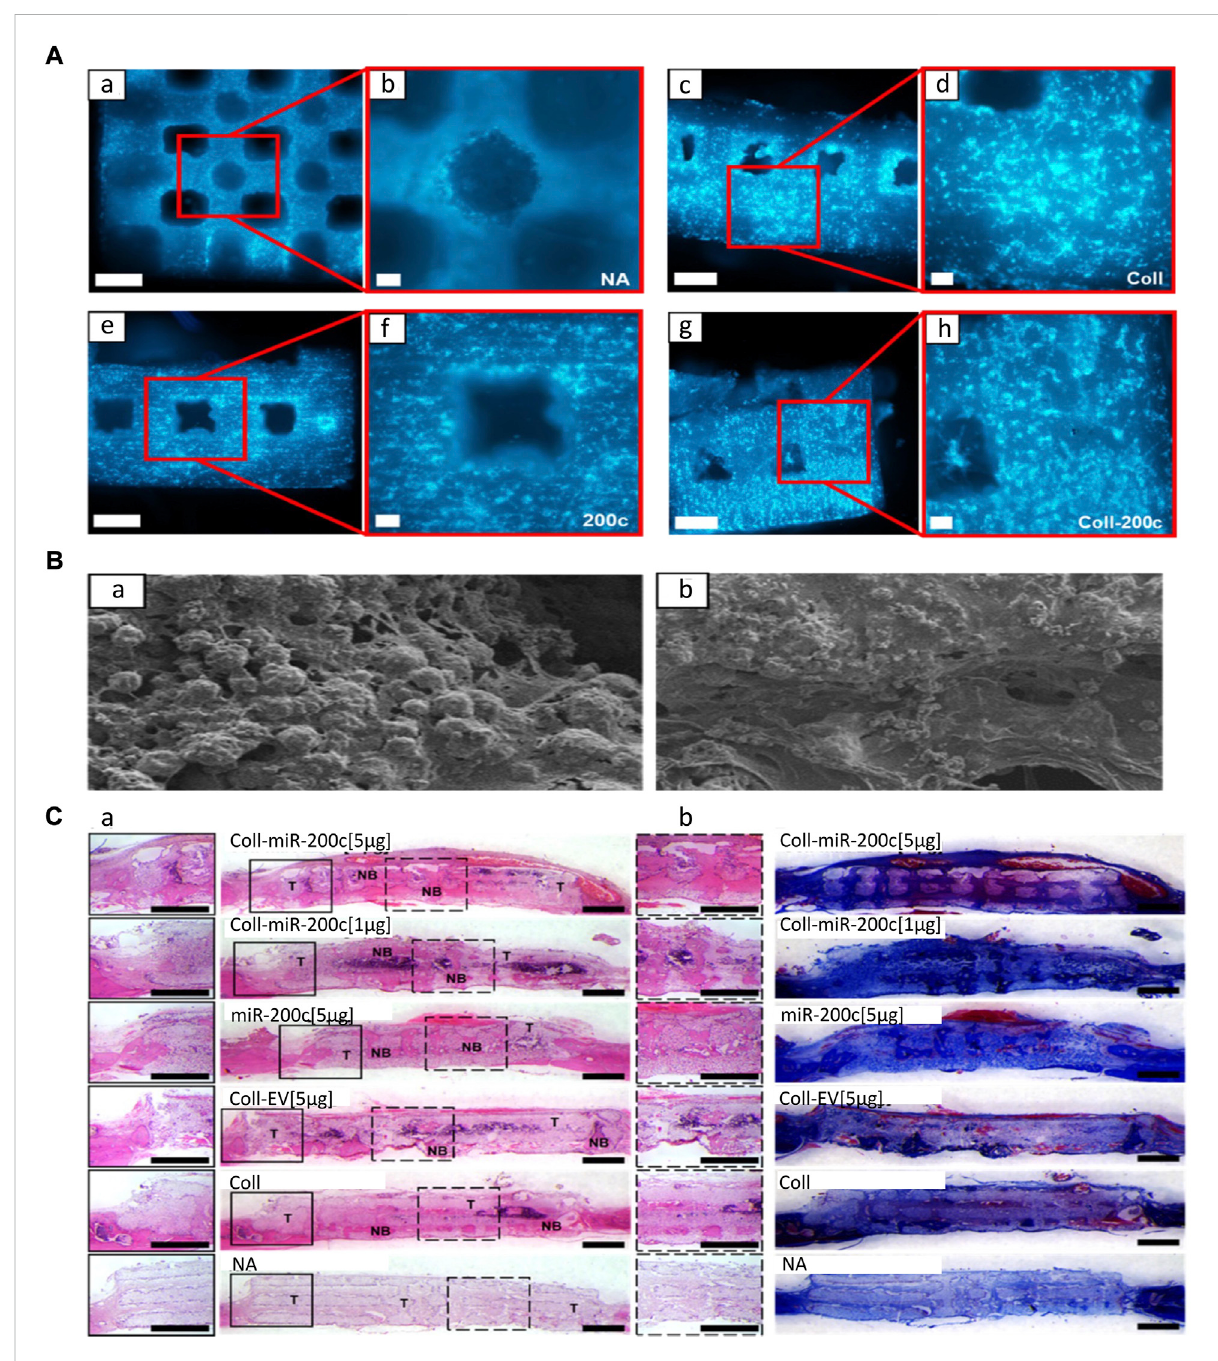
FIGURE 6 3D printing β -TCP scaffold loaded with miR-200c promotes bone regeneration (Remy et al., 2021). (A) DAPI nuclear staining image of hBMSCs on the β -TCP scaffold (A – H) . β -TCP scaffold without coating (A,B) ; collagen (Coll)-coated β -TCP (C,D) ; β -TCP containing miR-200c (E,F) ; collagen coating, β -TCP (G,H) bound by miR-200c. Scales: 100- μ m SEM images of the collagen network and matrix generated by 500 μ m (A,C,E,G) and 100 μ m (B,D,F,H) . (B) SEM images (100 μ m) of the collagen network and matrix of hBMSCs attached to the surface of β -TCP scaffolds. (C) H&E (A) andMTCstaining (B) ofratparietalbones4weeksafterimplantation.(Coll-miR-200c,collagen-coatedscaffoldcontainingmiR-200c;EV,empty vector; NA, β -TCP scaffold alone.) Copyright © 2021 The Authors. Reproduced with permission from the American Chemical